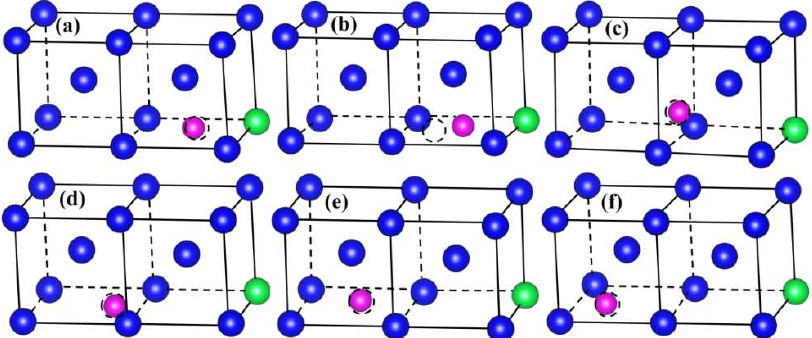
Figure 4. Occupation sites of He in W-Y system after structural optimization. Here, ( a – f ) represent He initial at different TIS of A-F, the dotted circles represent the initial occupied sites of He. The blue, green, and purple balls represent W, Y, and He atoms, respectively.